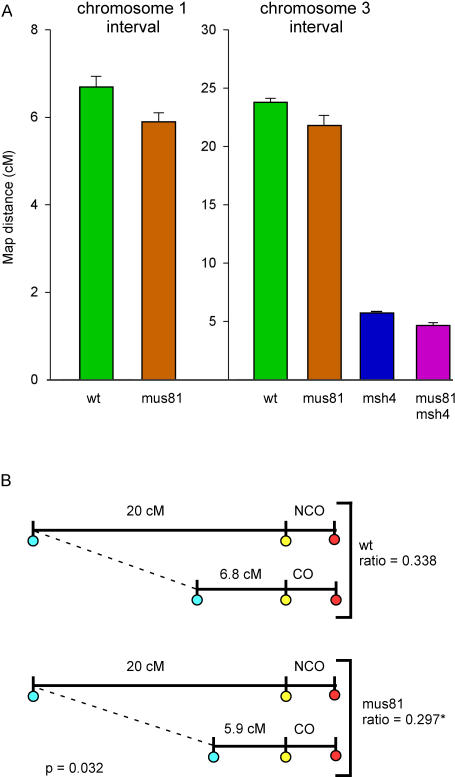
Meiotic Recombination in Atmus81 and Atmsh4 Mutants(A) Characterization of the meiotic recombination phenotype using intervals on Chromosomes 1 (left) and 3 (right). Green bars represent pooled data from wild type and heterozygotes, orange bars represent Atmus81 mutants, blue bars represent Atmsh4 mutants, and purple bars represent Atmus81/Atmsh4 double mutants. Error bars are +/− the standard error of the mean.(B) Interference analysis of the Atmus81 mutant using three linked markers on Chromosome 5. Each pair of graphs (wild type and heterozygotes top; Atmus81 bottom) shows the genetic distances of an interval without and with an adjacent CO. The ratios of these genetic distances with adjacent CO: without a CO were significantly different between the pooled wt/heterozygotes and Atmus81 mutants with a one-tailed p-value of 0.032 (see Materials and Methods for calculation of the p-value).